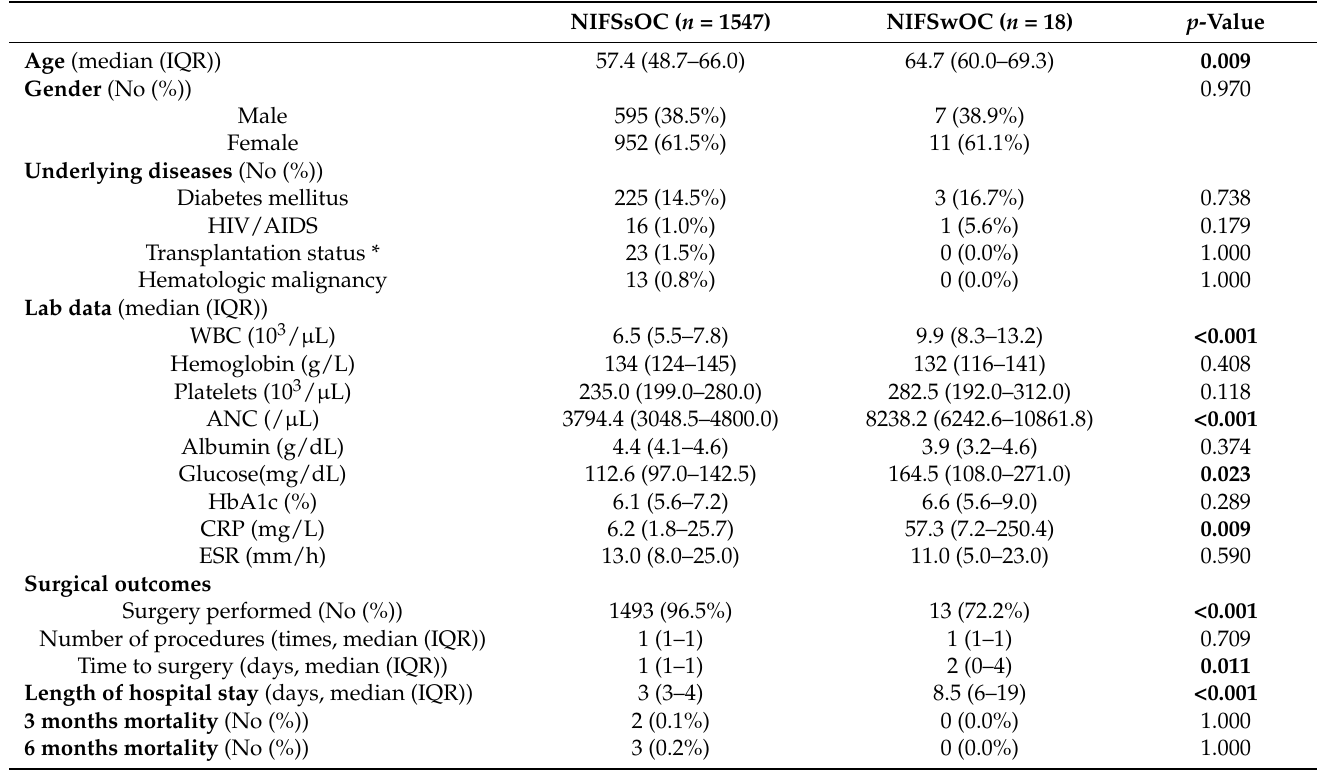
Table 2. Demographic data, laboratory results, surgical outcomes, morbidity, and mortality between the NIFSsOC and NIFSwOC